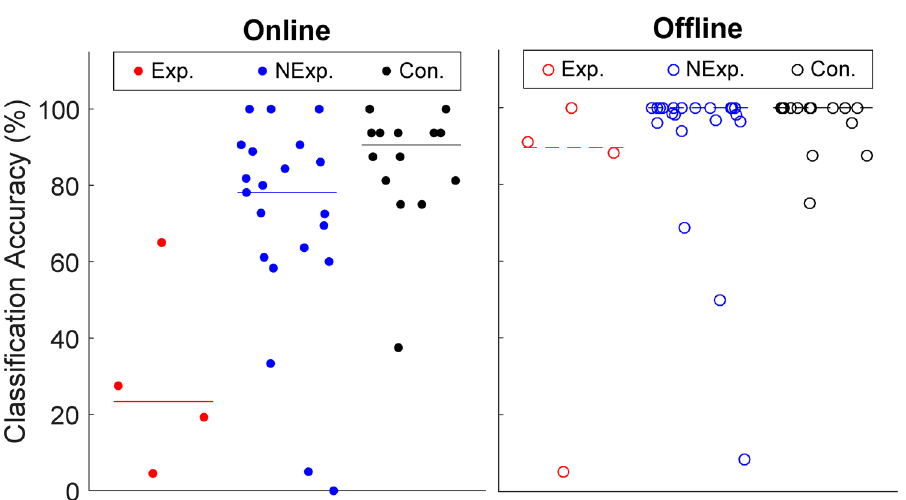
Figure 3. BCI accuracy for all study participants, with group medians represented by a horizontal line. Left: Median online accuracy for patients with the expansion was significantly less than controls (p = 0.005). Right: When analyzed offline, reduction in median accuracy in those with the expansion did not reach